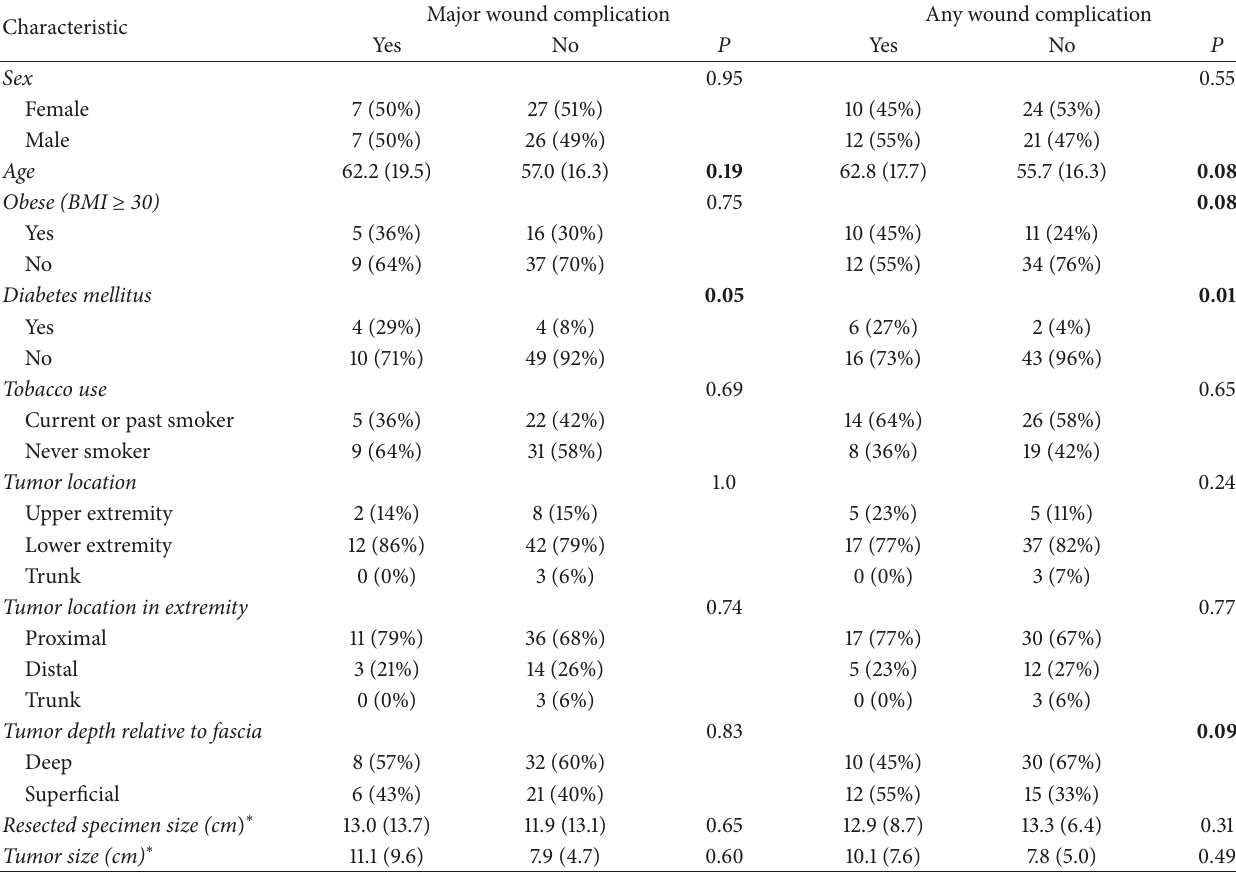
Table 1: Patient and tumor